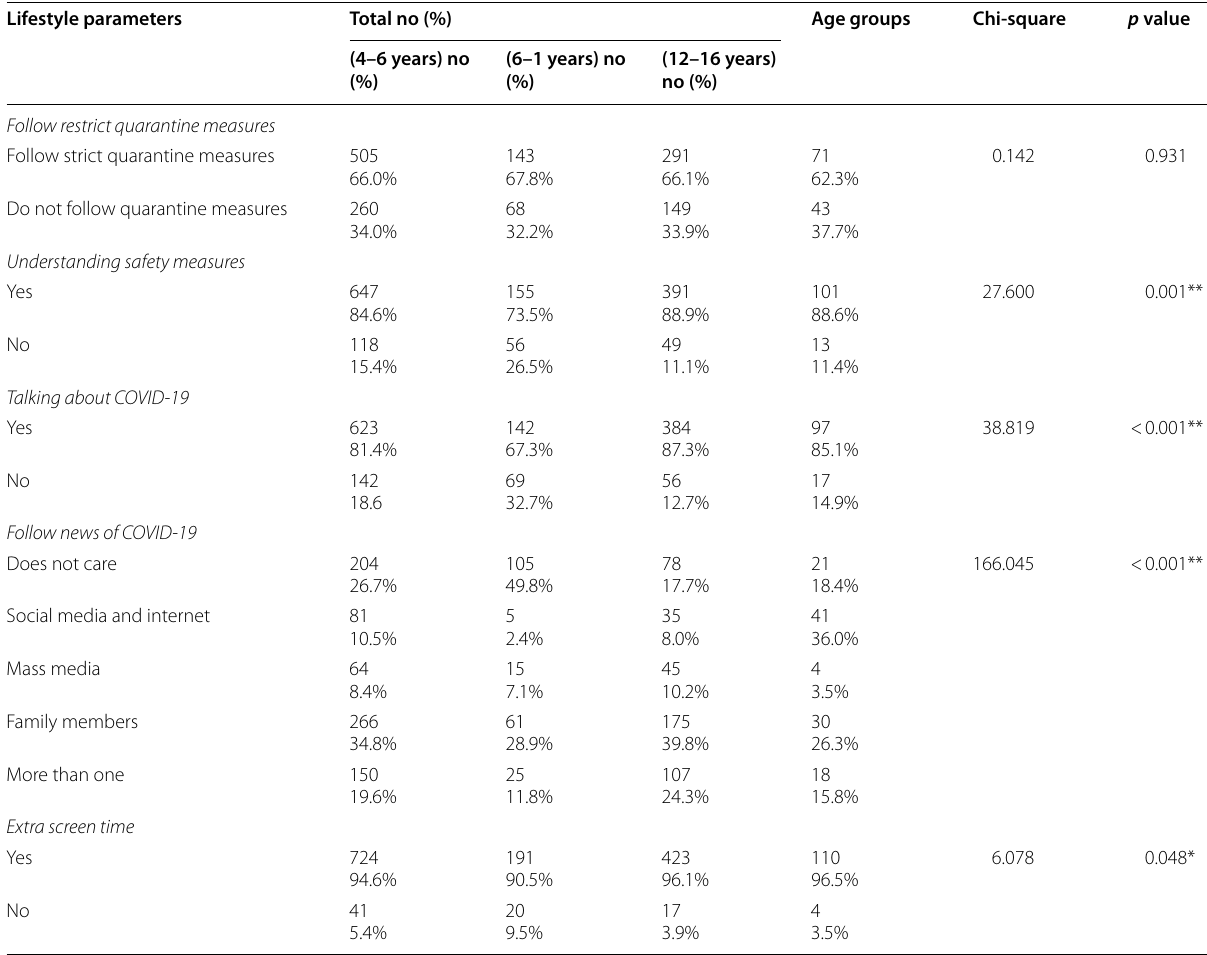
Table 2 Impact of lockdown on lifestyle according to age group